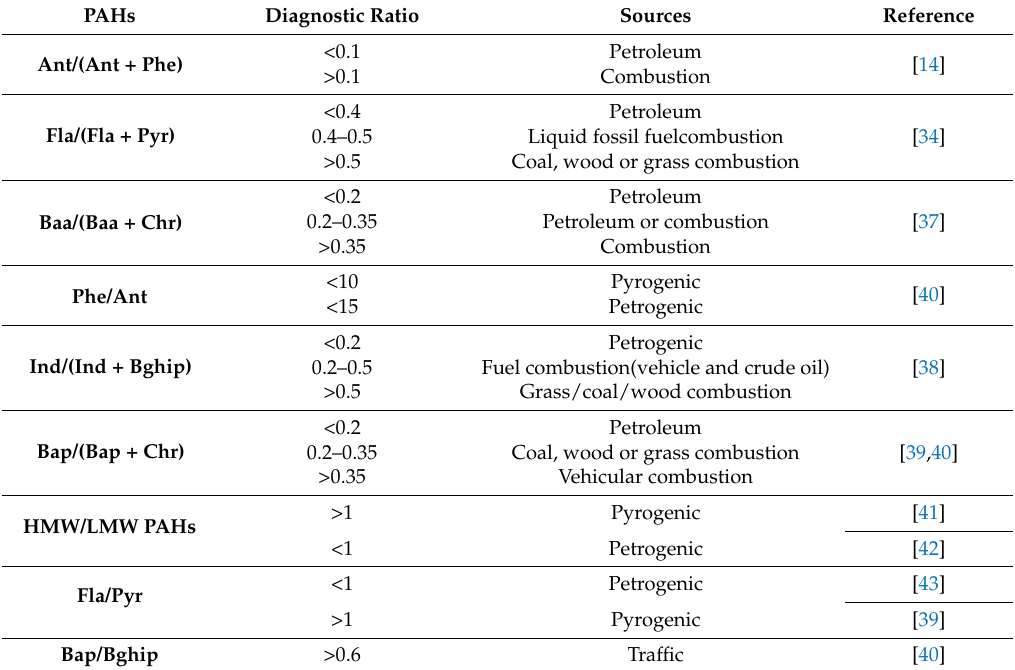
Table 2. Diagnostic ratios reported for PAHs in